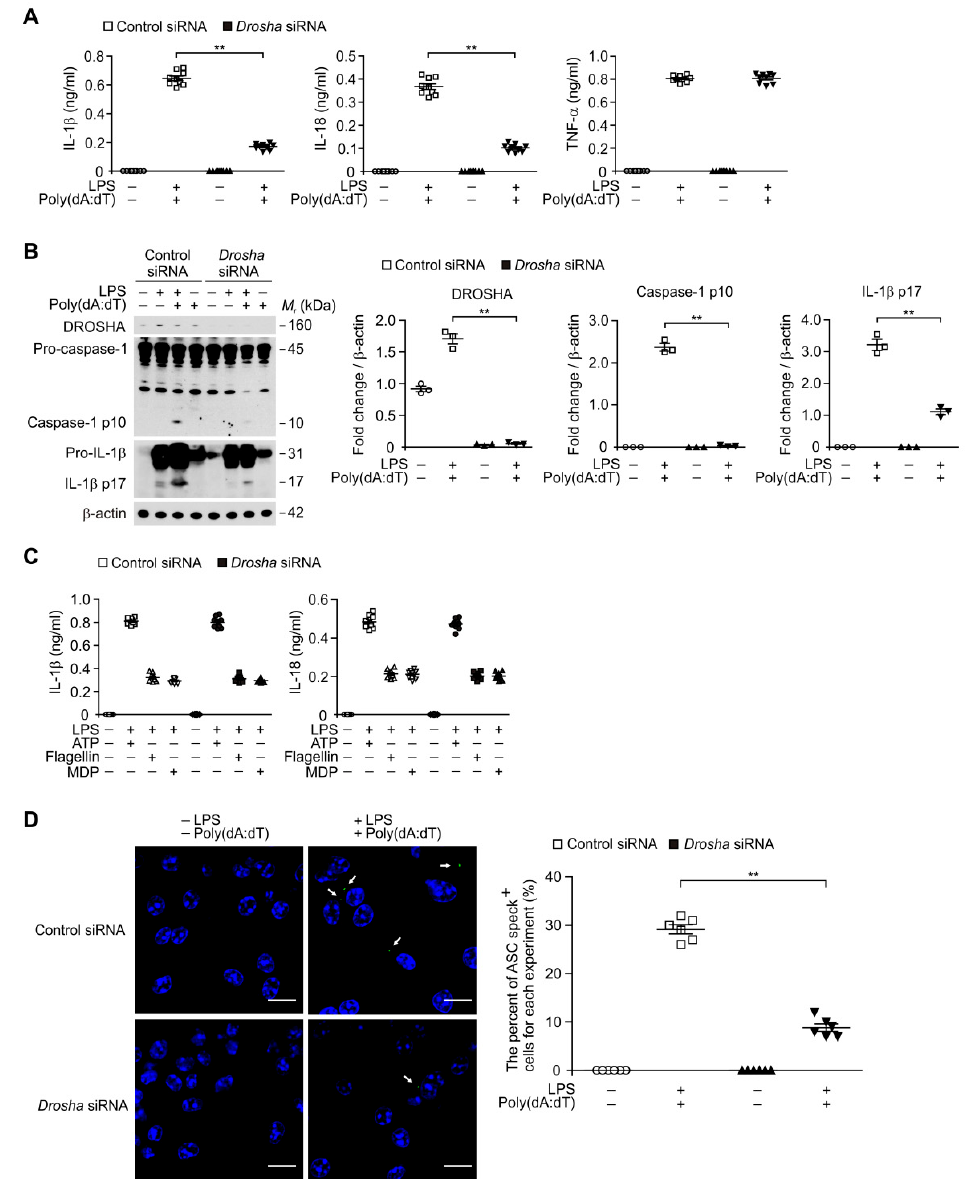
Figure 5. Deficiency of DROSHA suppresses AIM2 inflammasome activation in macrophages. ( A ) Quantification of IL-1 β (left), IL-18 (middle) and TNF- α (right) secretion from WT bone marrow-derived macrophages (BMDMs) transduced with DROSHA -targeting small interfering RNA ( Drosha siRNA), or with a control plasmid (Control), and stimulated with LPS and poly(dA:dT) ( n = 9 mice per group). ( B ) Representative immunoblot analysis for caspase-1 and IL-1 β (left) and densitometry quantification of caspase-1 p10 and IL-1 β p17 levels (normalized to levels of β -actin) (right) from WT BMDMs transduced with DROSHA -targeting siRNA ( Drosha siRNA), or with a control plasmid (Control), and stimulated with LPS and poly(dA:dT). For immunoblots, β -actin was used as loading control ( n = 3 mice per group). ( C ) Quantification of IL-1 β and IL-18 secretion from WT BMDMs transduced with DROSHA -targeting siRNA ( Drosha siRNA), or with a control plasmid (Control), and stimulated with LPS and either ATP, flagellin, or MDP ( n = 9 mice per group). ( D ) Representative immunofluorescence images (total 100 cells in 10 individual images per group) (left) and quantification (right) of ASC speck formation (white arrows) (the number of ASC speck positive cells in 10 individual images per group) in WT BMDMs transduced with DROSHA -targeting siRNA ( Drosha siRNA), or with a control plasmid (Control), and stimulated with LPS and poly(dA:dT). ( n = 6 mice per group). Scale bars, 20 µ m. Data are mean ± SEM. ** p < 0.01; by Student’s two-tailed t -test or